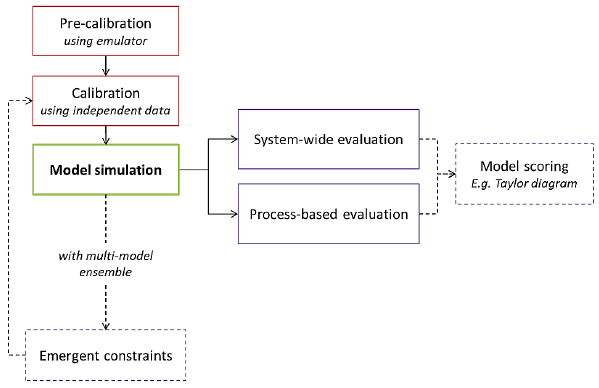
Fig. 4. Schematic diagram of model evaluation approaches, with optional approaches indicated by dashed